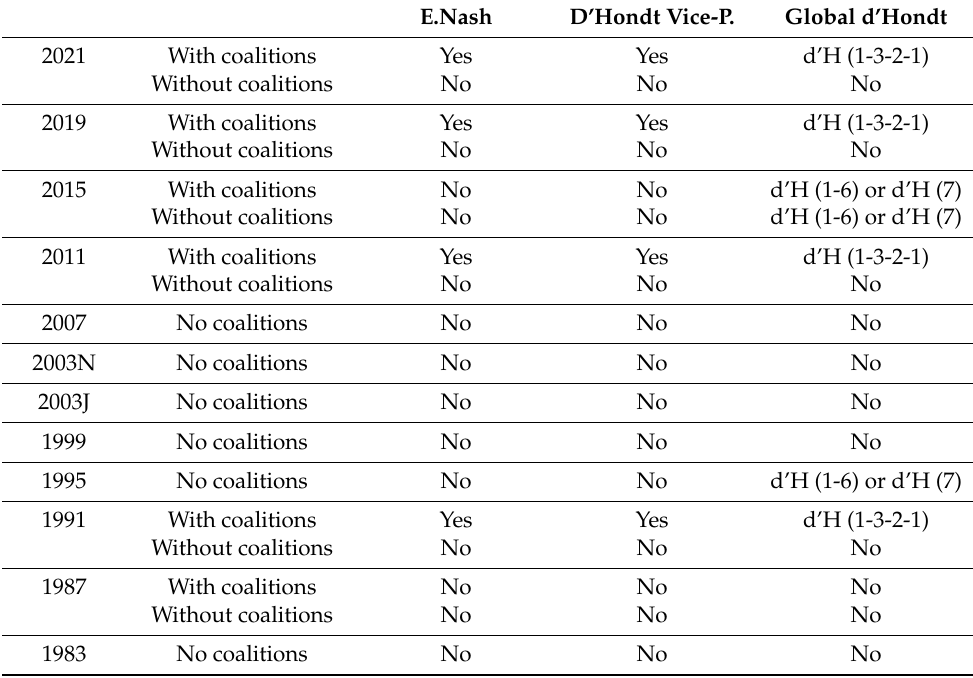
Table 12. Nash equilibrium and d’Hondt distribution by legislatures.